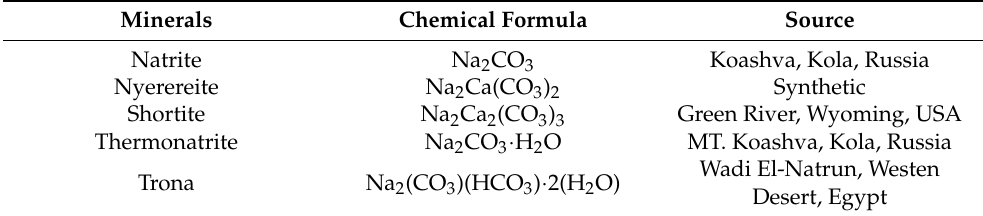
Table 1. Chemical formula, minerals name, and source for selected samples used in this